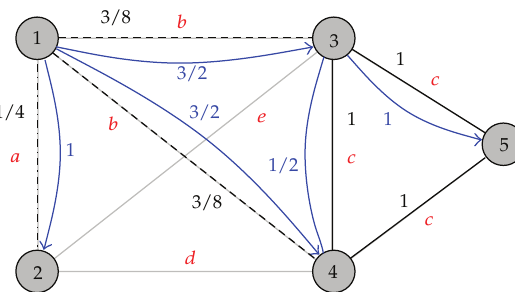
Figure 7: LP solution of SCF t with objective value f lp (cid:6) 1 (cid:9) 5 / 8 (cid:2) l a (cid:6) 1 / 4 ,l b (cid:6) 3 / 8 ,l c (cid:6) 1 (cid:3) . The blue arcs depict the flow variables with their according LP-values. Corresponding values for the edge variables are also shown. This solution is not valid for SCF tn , as the sum over the set of labels adjacent to node v 2 is smaller than one.